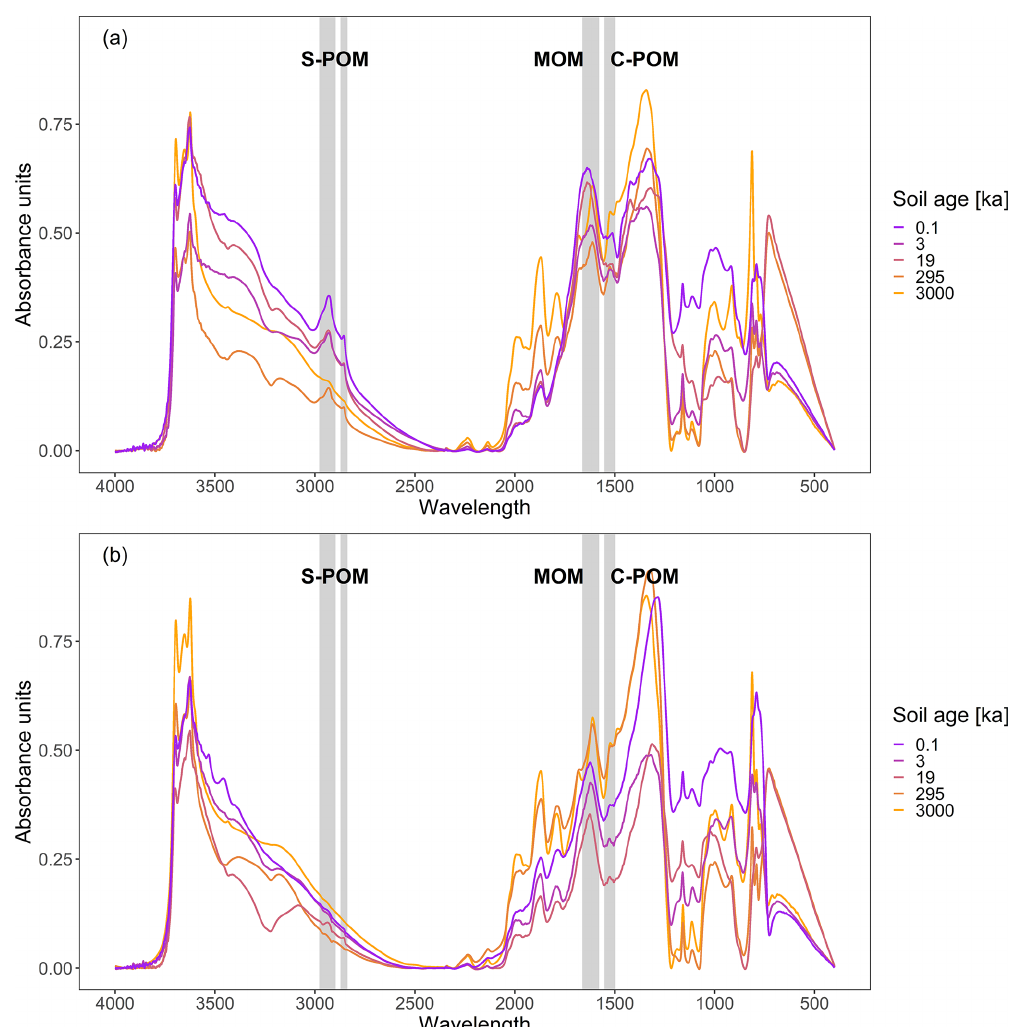
Figure 2. Baseline-corrected DRIFTS spectra of each soil age for 0–10 (a) and 10–30cm (b) soil depth. The wavenumber ranges across which absorbance peak areas were integrated for functional group assignment are indicated with grey bars in the background. The two wavenumber ranges around 2900cm − 1 stand for simple plant-derived OM (S-POM), the one around 1620cm − 1 for microbially associated OM (MOM), and the one at 1525cm − 1 for complex plant-derived OM